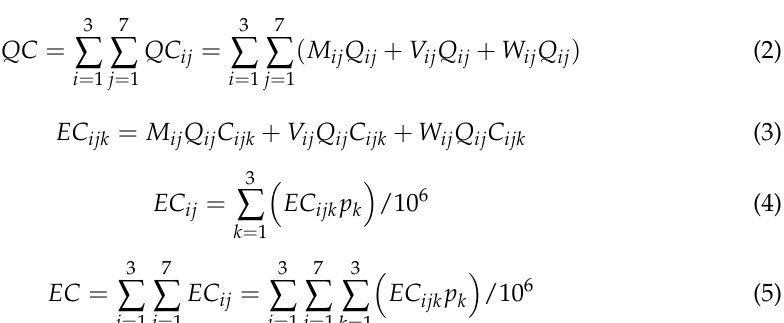
Table 6. Energy calorific value of energy consumption.